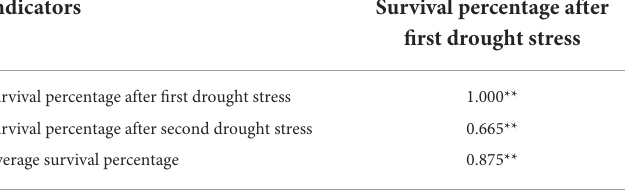
TABLE 4 Correlation analysis for parameters of drought screening at seedling stage. Indicators Survival percentage after